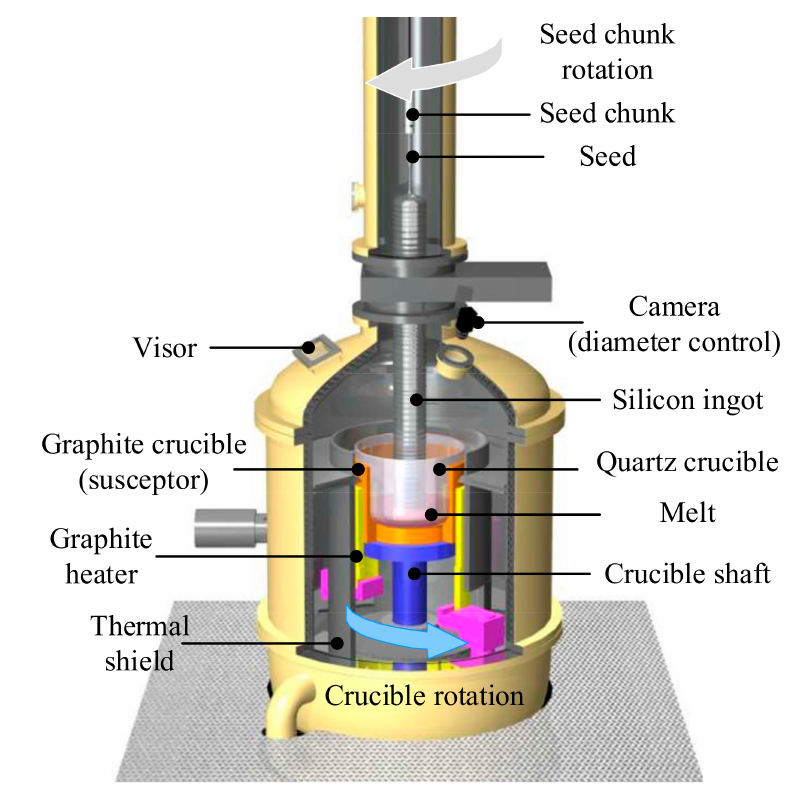
Figure 1. Structure of CZ single crystal